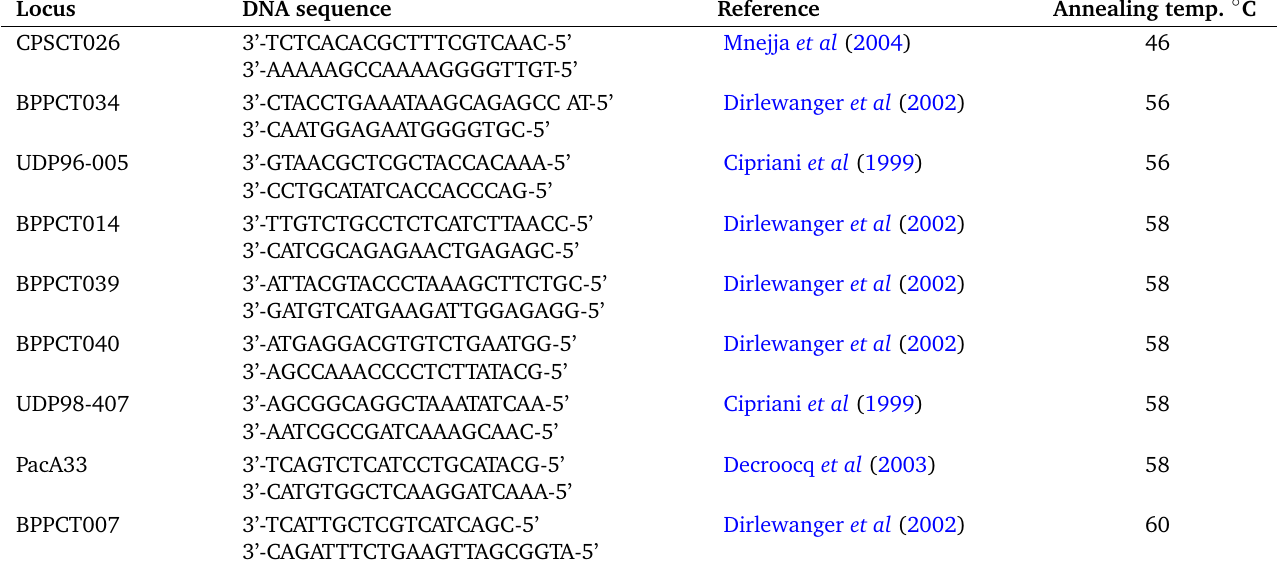
Table 1. SSR loci, DNA sequences, references and annealing temperature of the nine primer pairs selected by the ECPGR Prunus working group for assessment of plum accessions .